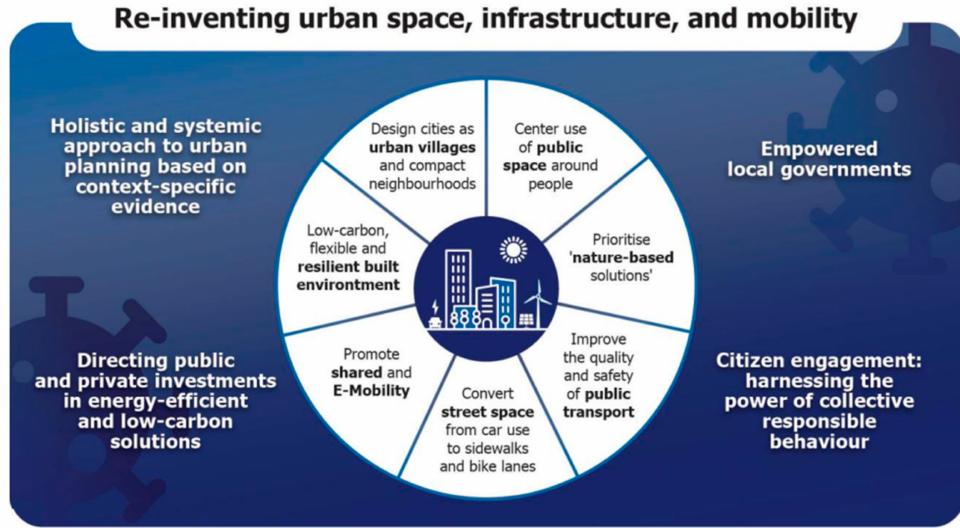
Figure 3. Role of urban space, infrastructure, and mobility in sustainable energy transitions